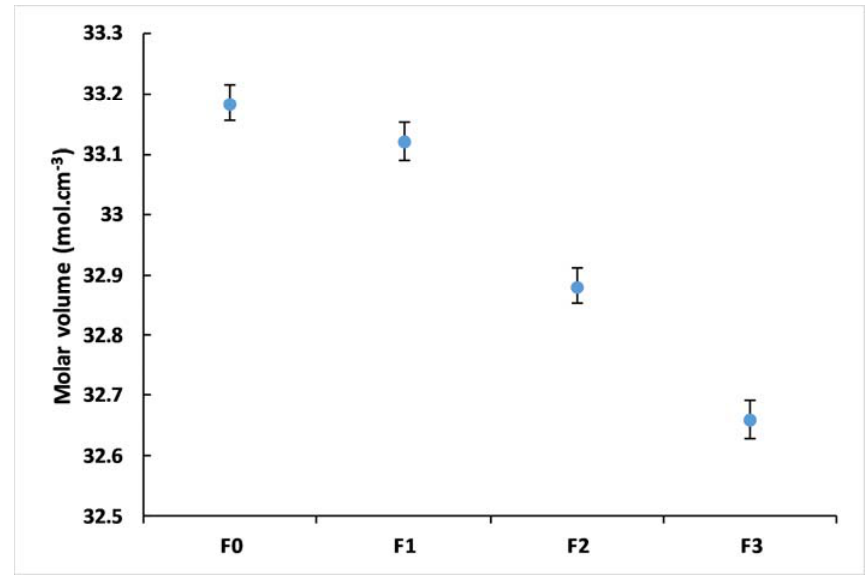
Figure 4. Molar Volume of F 0 , F 1 , F 2 , and F 3